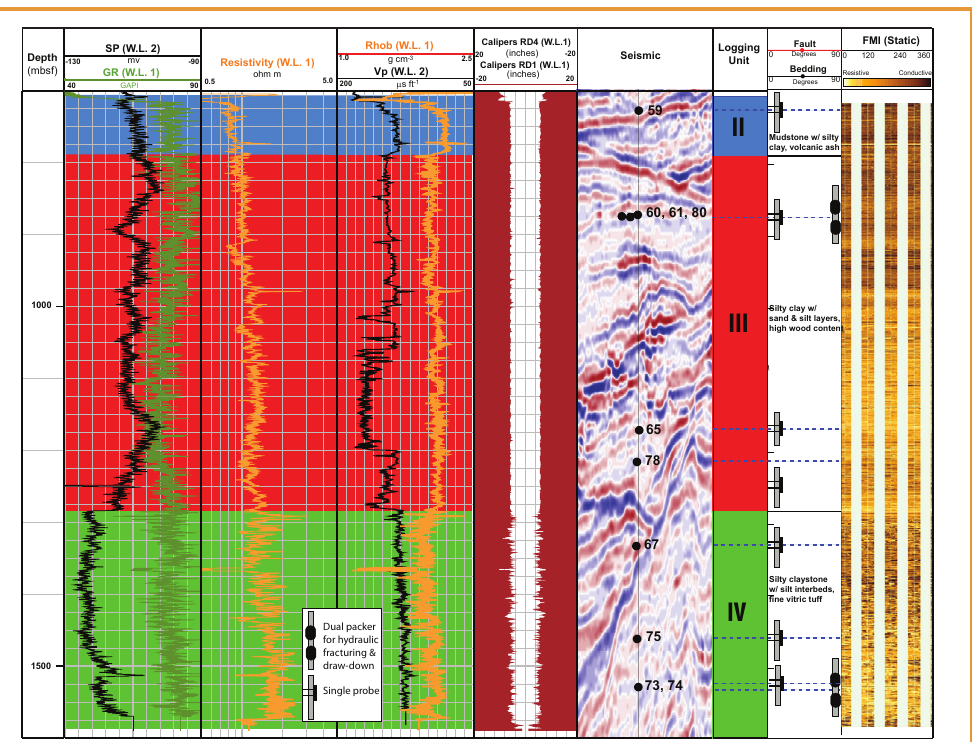
Figure 3. MDT test points on the seismic cross section together with some important logging data and their interpretation. (From left to right) Depth (meter below seafloor), wireline logging runs (W.L.), Spontaneous potential, gamma-ray, resistivity, density, p-wave velocity, EMS calipers, MDT test points on seismic, logging unites from cuttings/core-log-seismic integration, dip picks from FMI data and static-normalized FMI image.